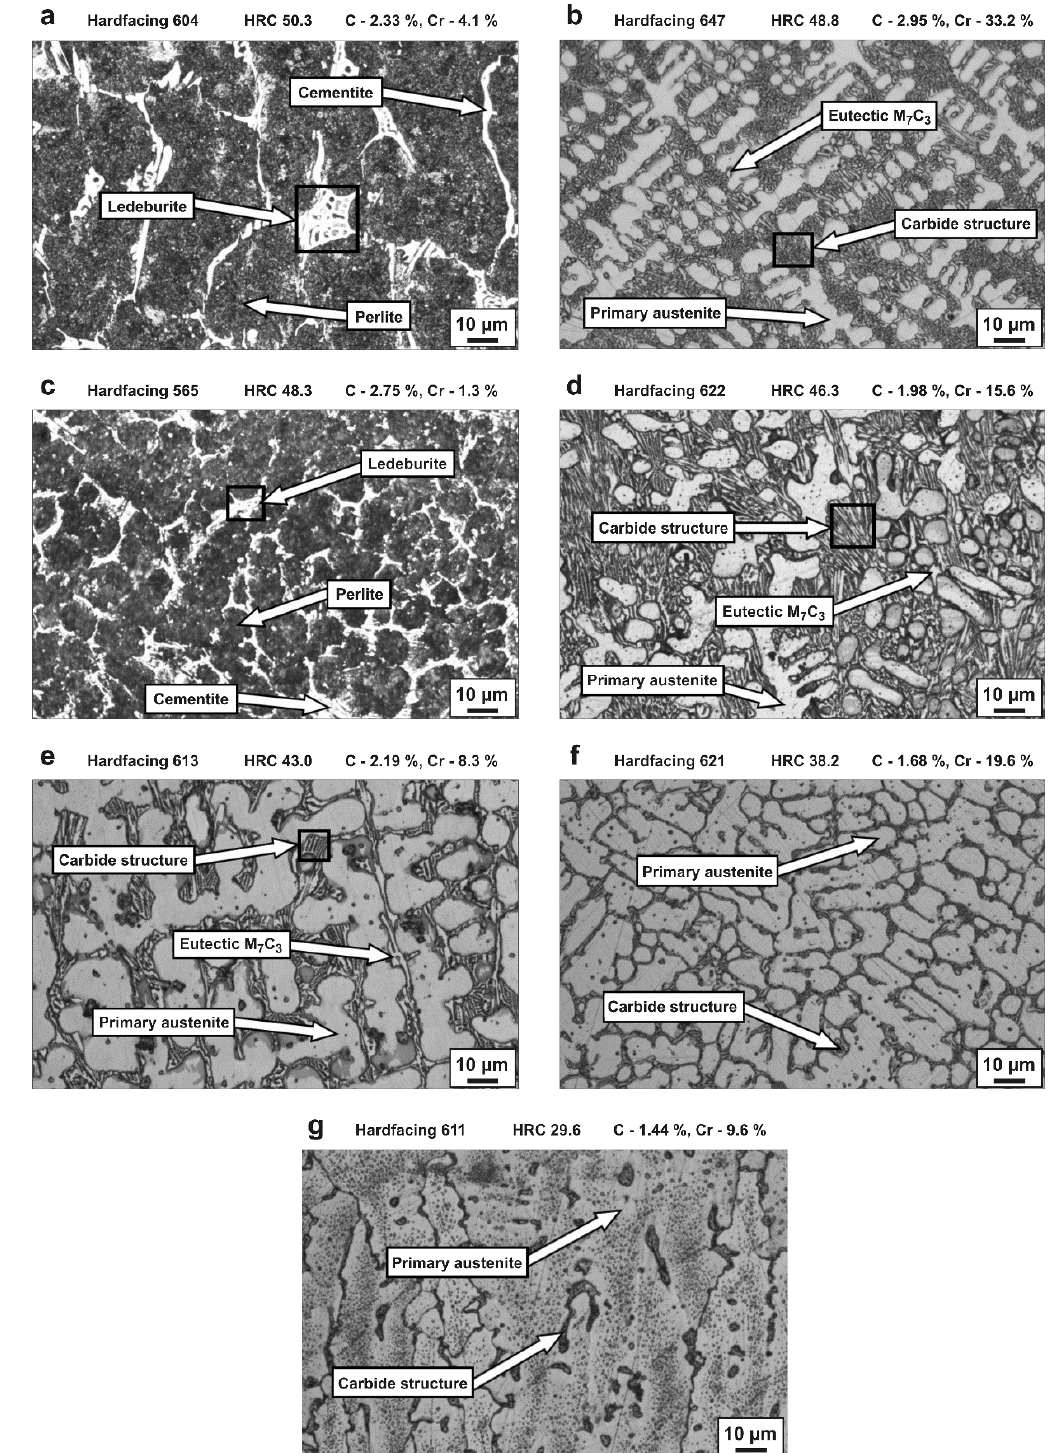
Figure 5. Optical images of the characteristic samples sorted according to their hardness (provided along with the content of the main elements).